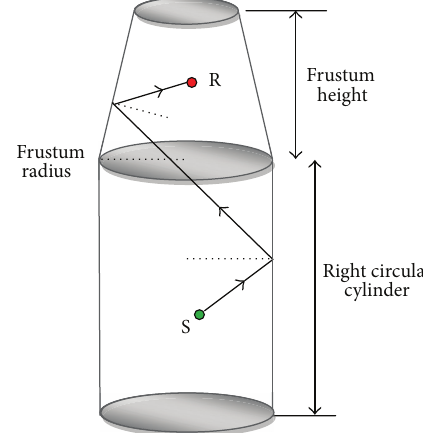
Figure 3: Schematic of the ray propagation inside a space vehicle. adapted for convergence of ray solutions at the receiver. Each ray is uniquely defined by its (𝜃, 𝜙) values. The rays are then allowed to propagate inside the cabin. The first intersection point is determined by the intersection formula between a line and the surface of the corresponding hybrid structure